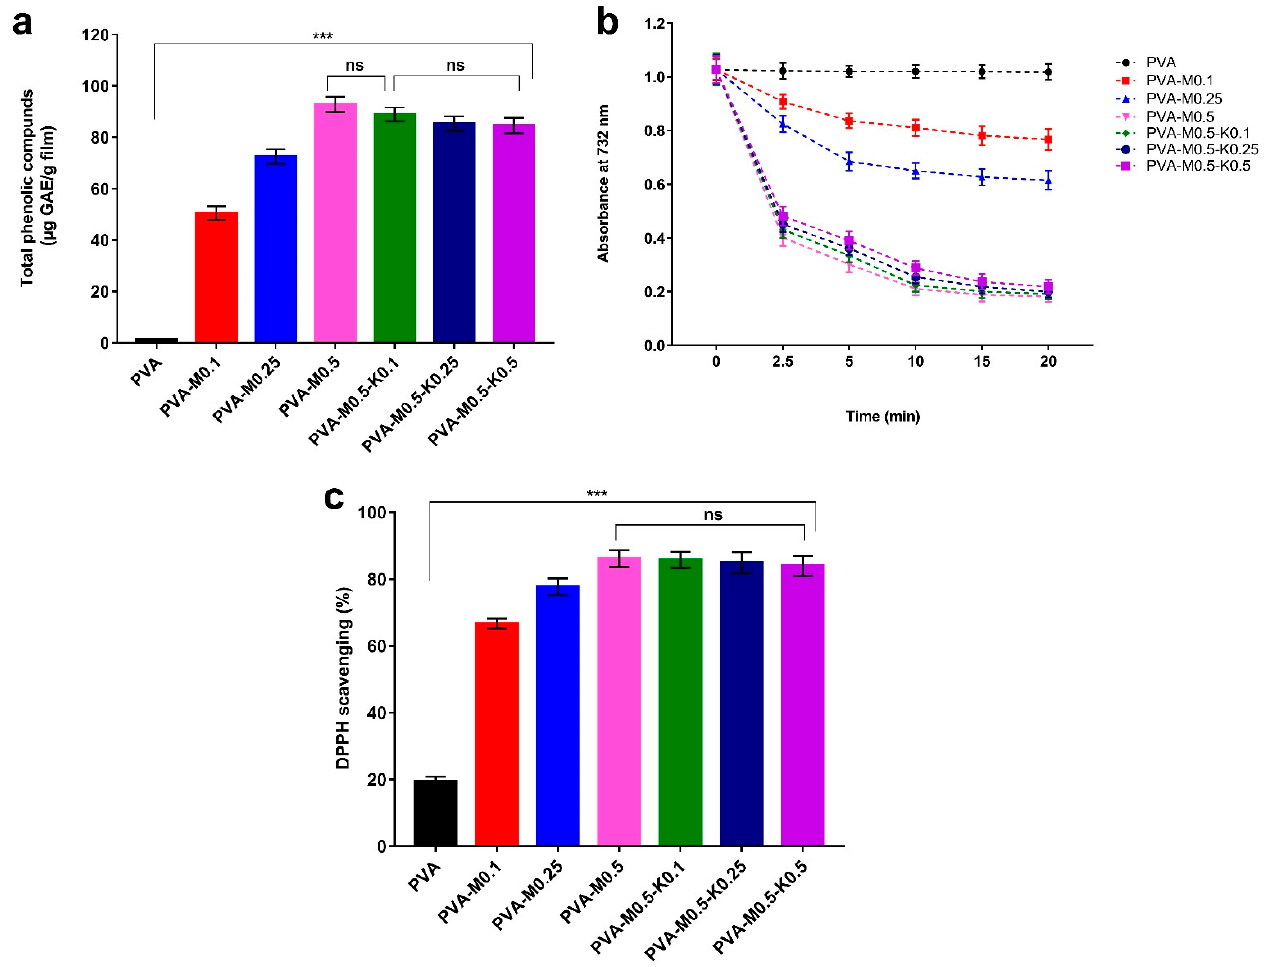
Figure 8. ( a ) Total phenolic compounds released from PVA/marjoram, and PVA/marjoram/kaolin composite sponges, ( b ) Time-dependent decolourization of ABTS • + dye by PVA/marjoram, and PVA/marjoram/kaolin composite sponges, and ( c ) Scavenging competency of DPPH free radical by PVA/marjoram, and PVA/marjoram/kaolin composite sponges. Results are presented as means ± SD ( n = 5) (*** p < 0.001, and (ns) points to a non-significant difference).